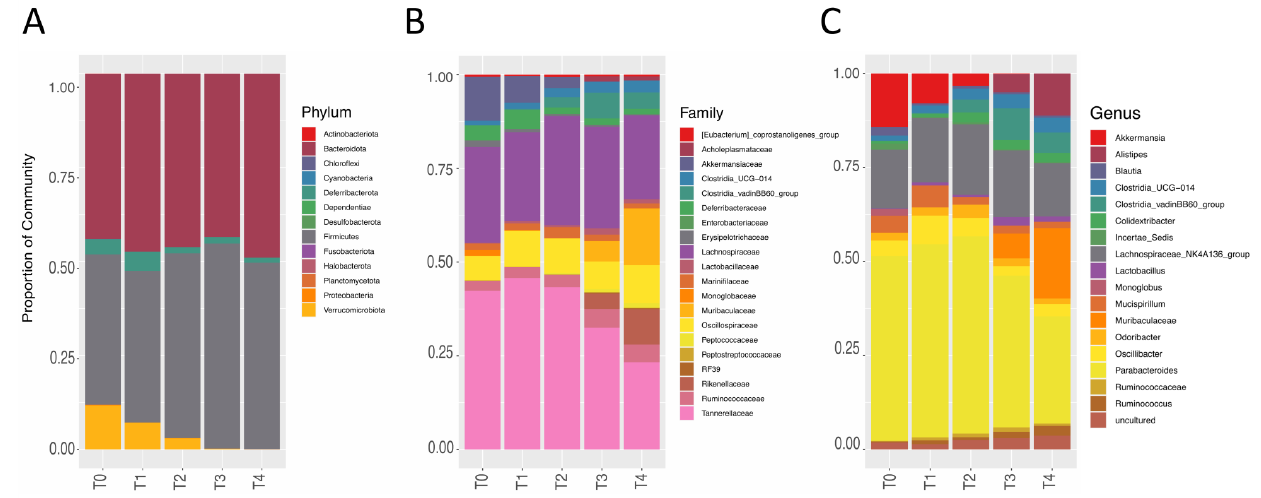
Figure 4. Bar chart regarding the distribution of the most abundant phyla ( A ), families ( B ), and genera ( C ). The proportion of stack in bar chart corresponds to the total amount of reads of the most abundant phyla, families and genera. (Number of animals: T1 n = 14, T2 n = 12, T3 n = 14, and T4 n =